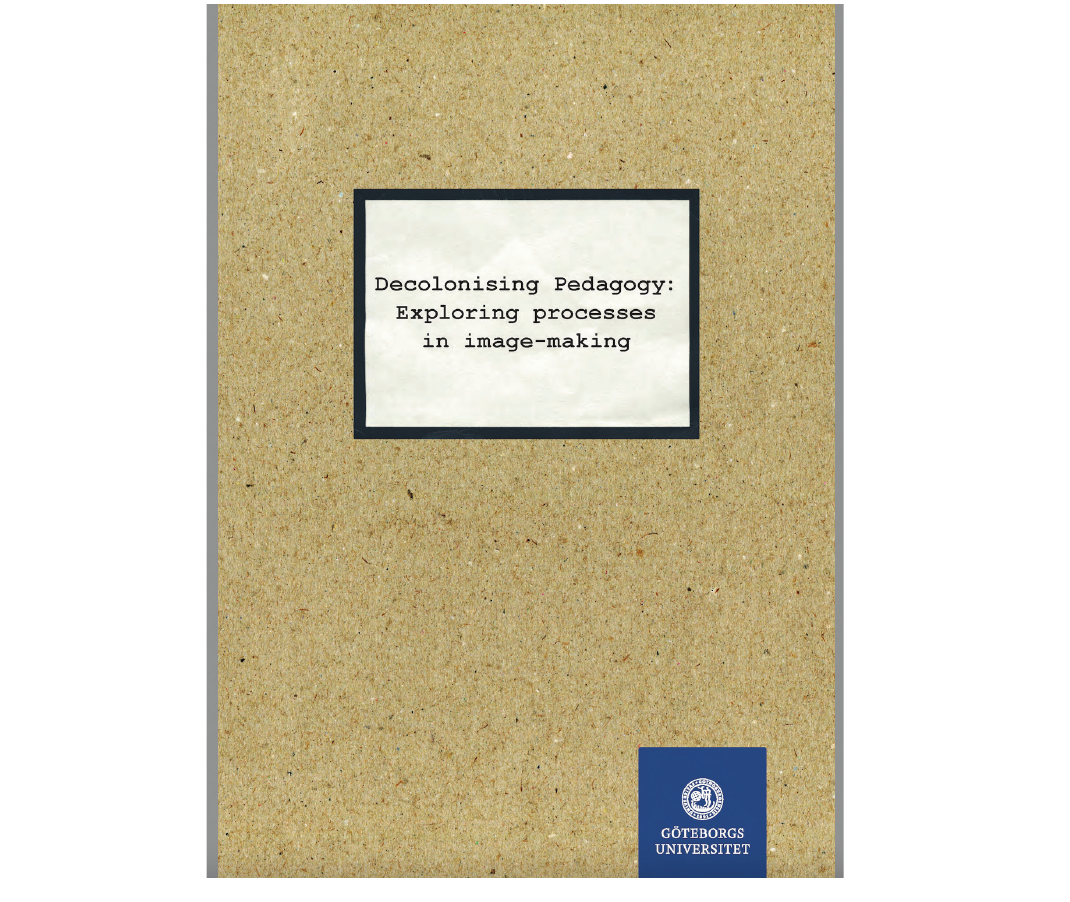
Figure 1. Cover of programme: materials in the notebook included resource materials for the workshop and references (Source: Jyoti